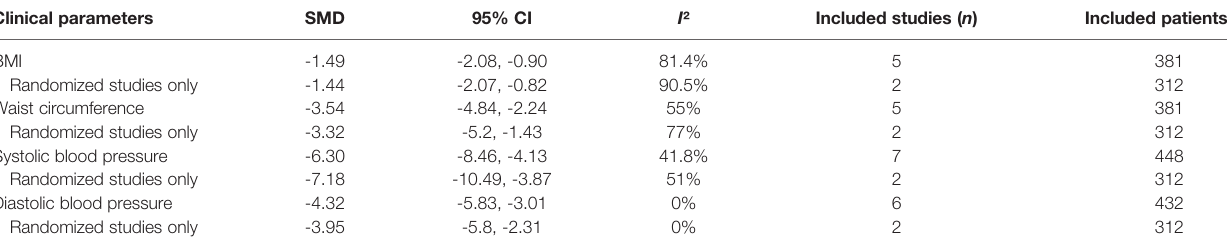
TABLE 3 | Summary of meta-analysis on the improvement of comorbidities with pasireotide. Clinical